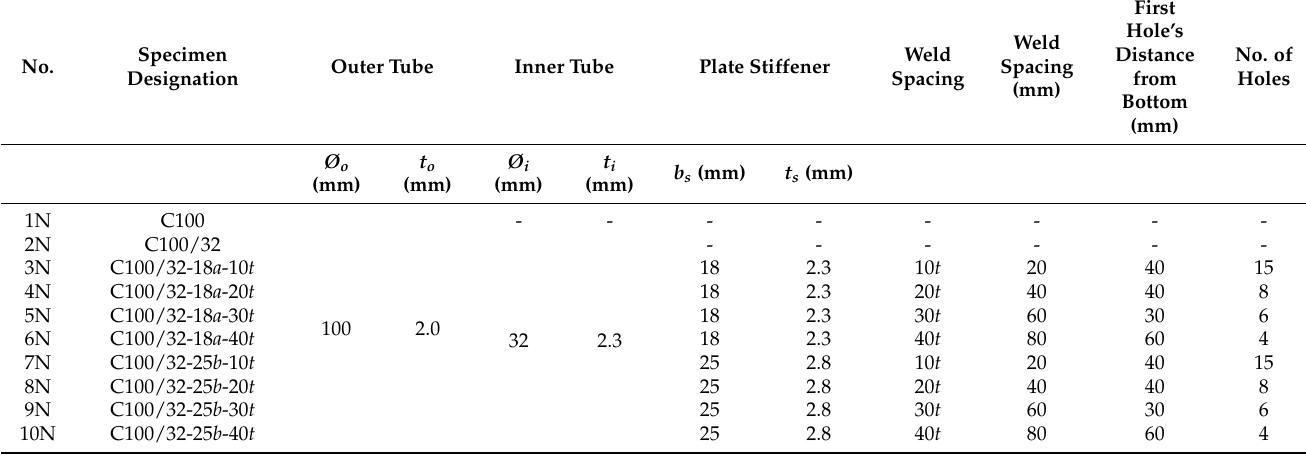
Table 2. Specifications for the circular